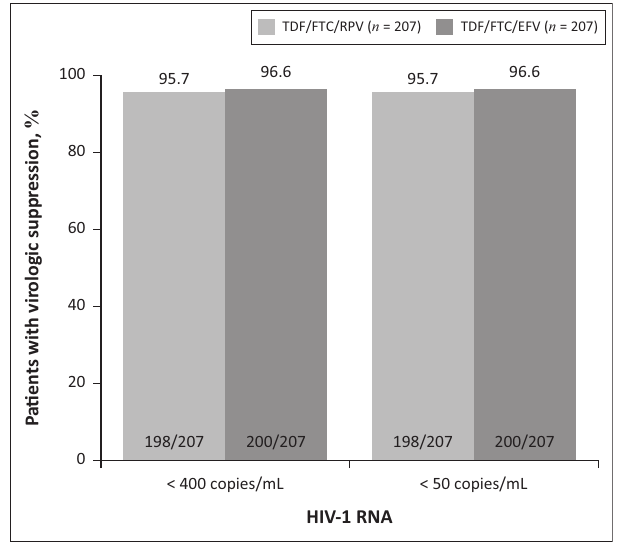
FIGURE 3: Plasma HIV-1 RNA < 400 and < 50 copies/mL at week 48 (PP population, modified FDA Snapshot). TABLE 2: Virologic response (HIV-1 RNA <400 copies/mL) by subgroups at week 48 (ITT, modified FDA Snapshot). Variable NNRTI at screening EFV